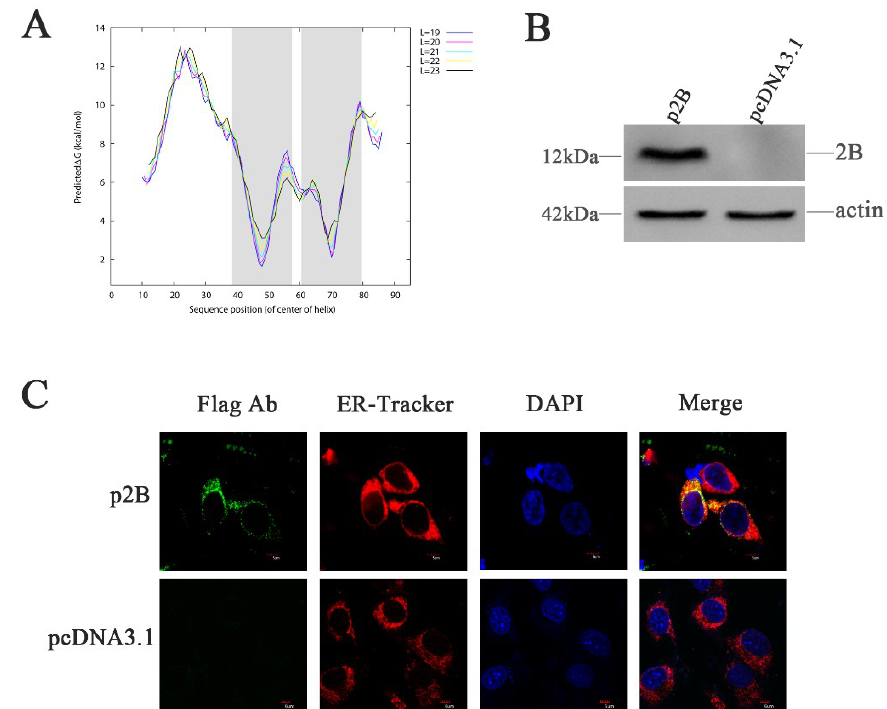
Figure 4. HRV16 2B is localized to the ER. ( A ) Hydrophobic domain analysis of HRV16 2B. The shadow shows the two hydrophobic regions predicted in the protein according to ∆ G Prediction Server (http://dgpred.cbr.su.se/). ( B ) H1-HeLa cells were transiently transfected with p2B or pcDNA3.1 plasmid for 24 h. The cells were then lysed and analyzed for the expressions of the 2B protein by Western blotting. ( C ) H1-HeLa cells were transfected with p2B (with Flag-tag). The ER and nuclei were visualized by staining with ER-Tracker Red and DAPI, respectively, and analyzed by a confocal microscope. Scale bars of images, 5 μm.